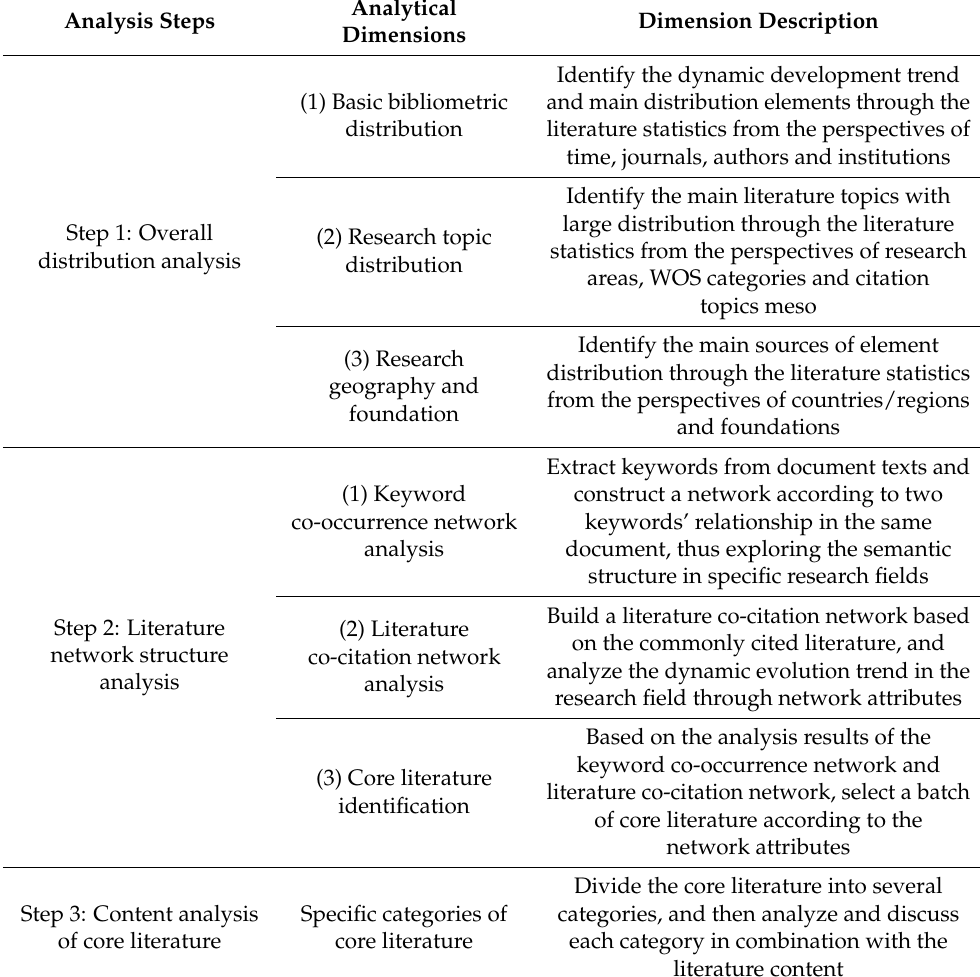
Table 1. The systematic literature analysis